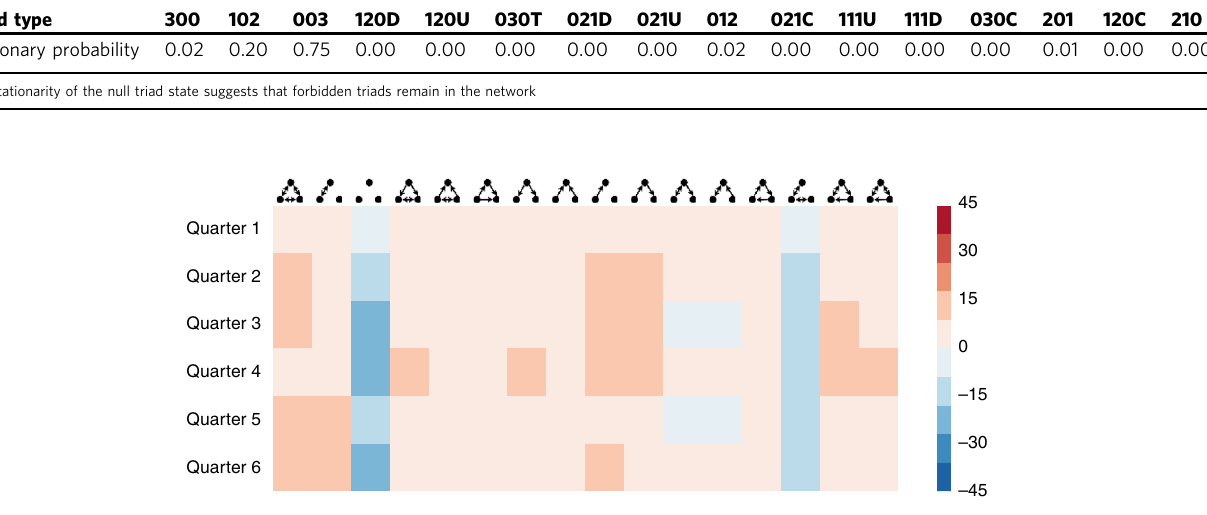
Fig. 3 The difference in the number of standard deviations of the observed network from 10,000 suitably randomized networks. Warm colors mean more probable than random, while cold colors mean less probable. The observed networks are statistically and signi fi cantly more balanced than randomized networks